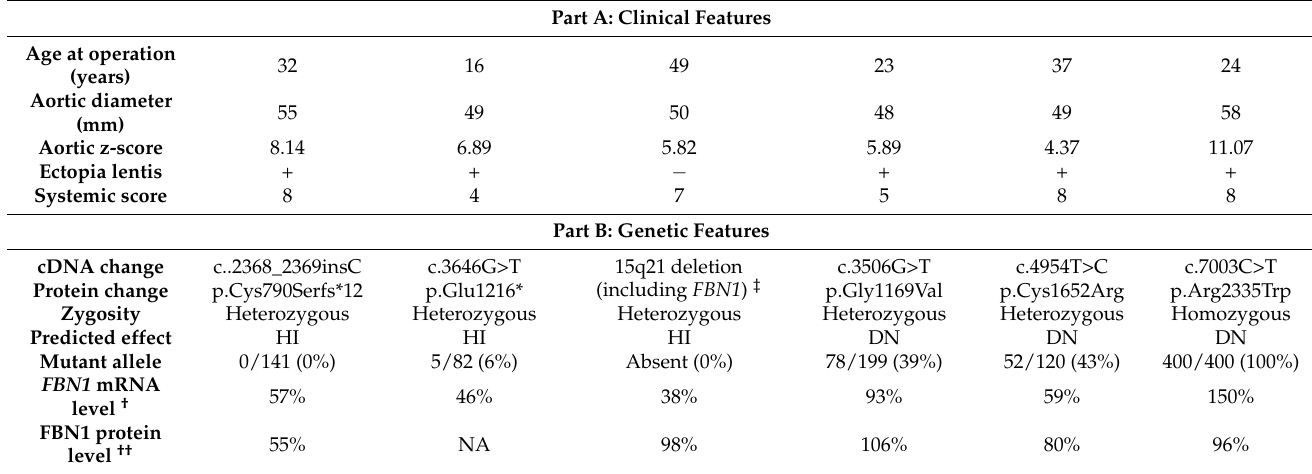
Table 1. Clinical and genetic features of patients with